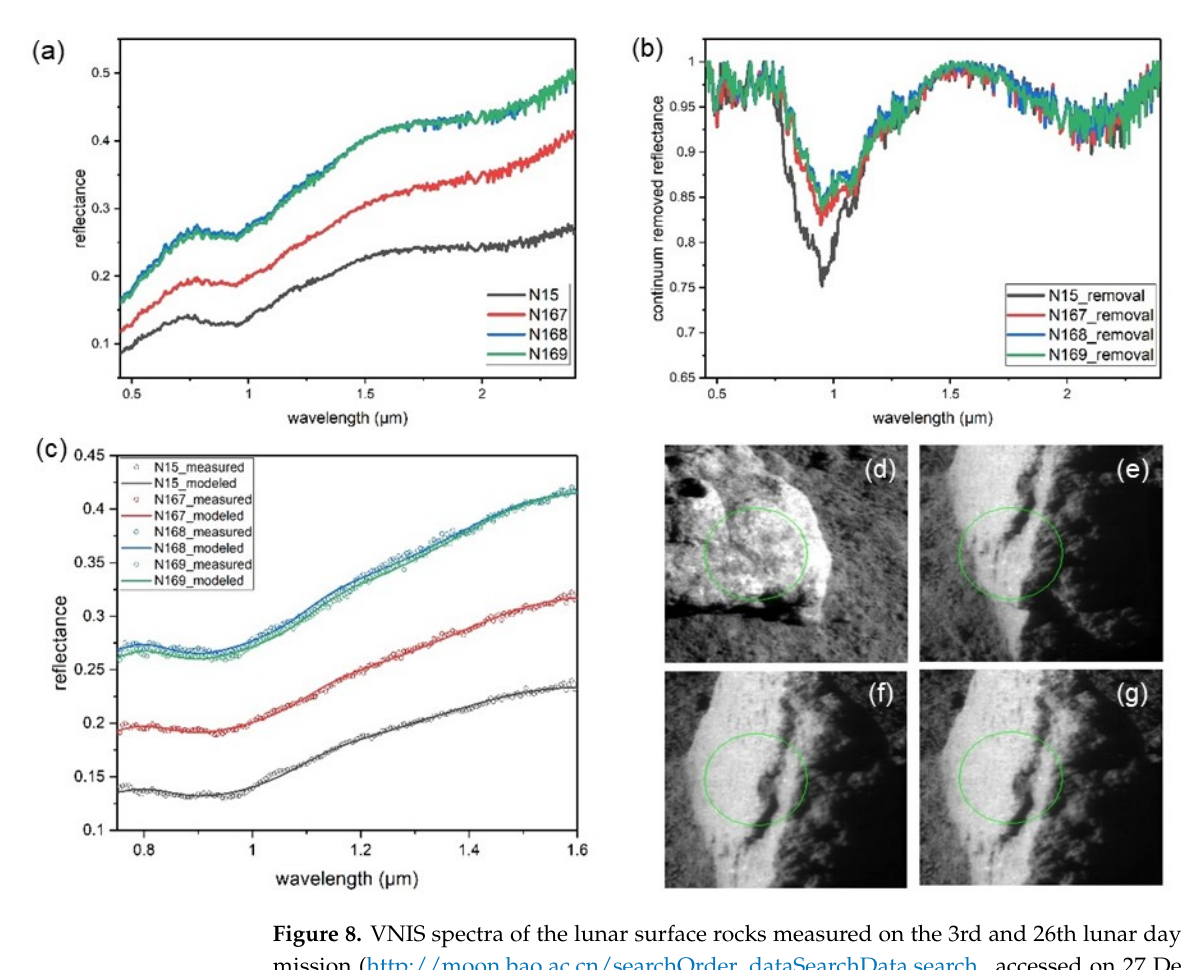
Figure 8. VNIS spectra of the lunar surface rocks measured on the 3rd and 26th lunar days of the mission (http://moon.bao.ac.cn/searchOrder_dataSearchData.search. accessed on 27 December 2021). The spectra were photometrically corrected using the phase function derived by Yang et al. (2020) [26]. ( a ) The initial spectra of the Chang’e-4 rocks. ( b ) The continuum removed spectra of the